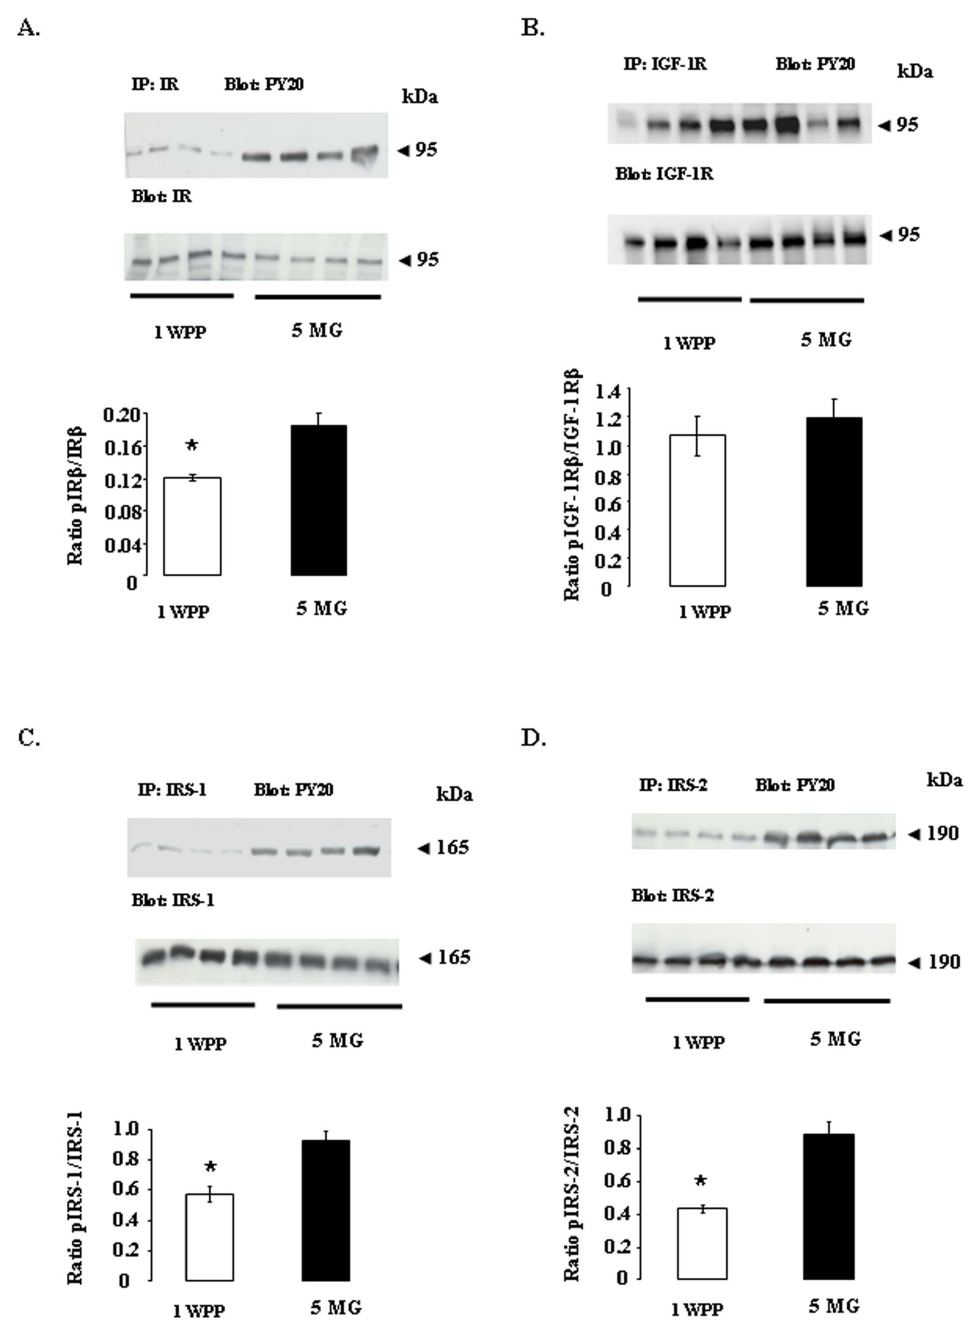
Figure 4. Levels of tyrosine phosphorylation for IR, IGF-1R, IRS-1 and IRS-2 in bovine adipose tissue at one week post partum (1 WPP) and 5 months of gestation (5 MG). Western blots showing the tyrosine phosphorylation levels of IR b (A), IGF-1R b (B), IRS-1 (C) and IRS-2 (D) in adipose tissue lysates from dairy cows at one week post partum (1 WPP, n =8 animals) and 5 of months gestation (5 MG, n =8 animals). Immunoprecipitation (IP) was performed before gel electrophoresis. The antibody used is indicated as follows: IP: molecule X; the immune sera used to determine protein phosphorylation levels are indicated to the left of the gels (e.g., PY20 is directed against anti-phosphotyrosine residues). The levels of phosphorylation of IR, IGF-1R, IRS1 and IRS-2 were normalized with respect to the corresponding total protein, with specific antibodies, as indicated to the left of the gels. The gels show protein bands, which are underlined for each group, with four dairy cows per group. From left to the right, the groups are 1 WPP and 5 MG. Below each gel, the histograms show the mean 6 SEM for a total of n =8/group. *indicates a significant difference ( p , 0.05). doi:10.1371/journal.pone.0093198.g004 carrying out an immunohistochemical study with a specific resistin in white adipose tissue (Figure 6C). As a negative control, antibody directed against human resistin (the same antibody used we replaced the primary antibody with PBS or normal serum. No for immunoblotting). We observed intense immunostaining for immunoreaction was observed for the negative controls.